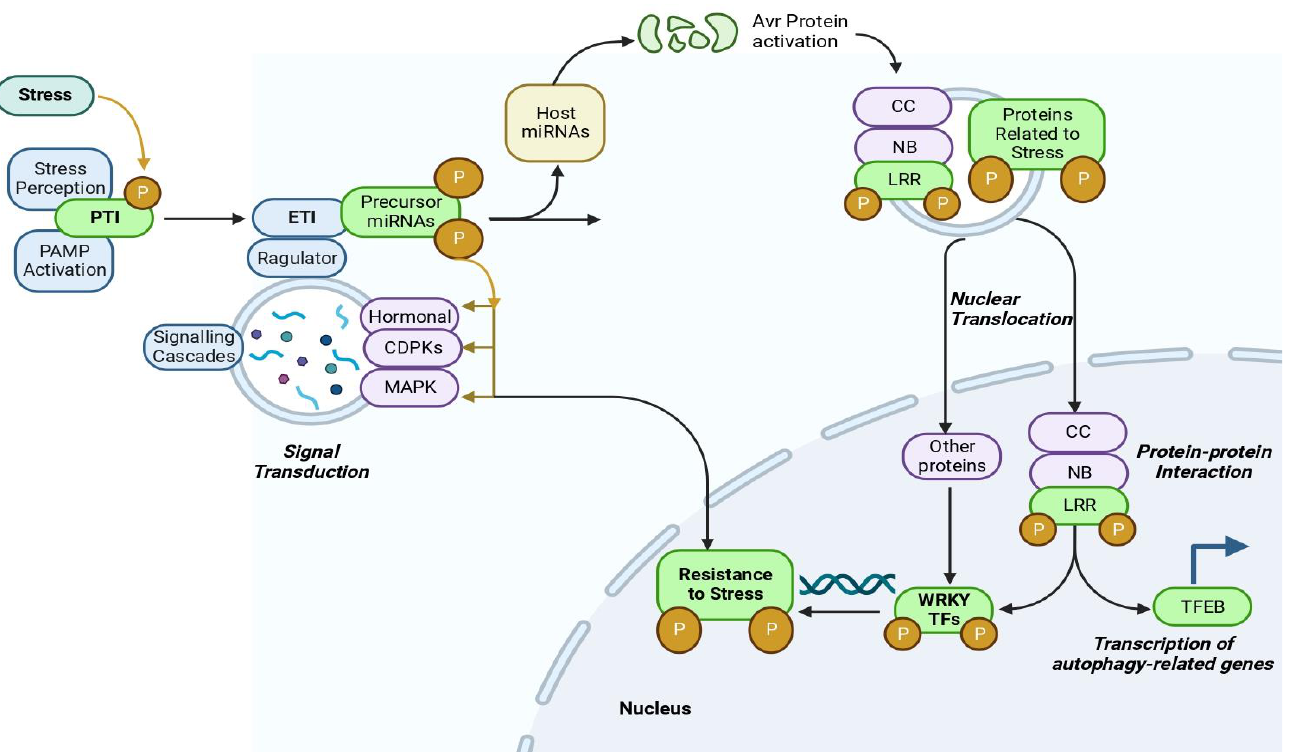
Figure 4. Schematic representation of the molecular mechanism for combined abiotic stress endorse- ment in crop plants.